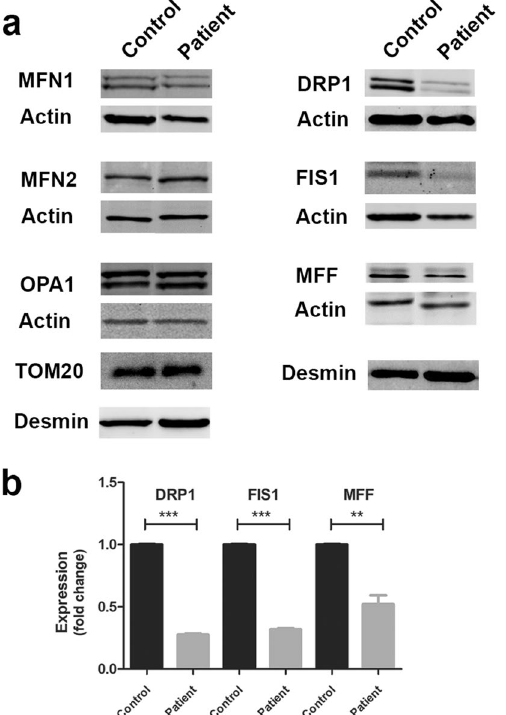
mitochondrial fusion (MFN1: 84 kDa, MFN2: 86 kDa, OPA1: 80-100 kDa) and fission (DRP1: 79-84 kDa), MFF: 25-38 kDa), FIS1: 15 kDa). While actin was used to control equal loading, muscle specific expression patterns of proteins were eveluated by comparing the levels of proteins to desmin. ( b ) Graphs showing the quantitative analysis of Western blotting by ImageJ. The asterisk in the graph indicates the significant p value obtained by Student’s t- test (** p < 0.01, *** p < 0.001), and the error bar indicates the standard deviation. Uncropped images of Western blotting are shown in Supplementary figure